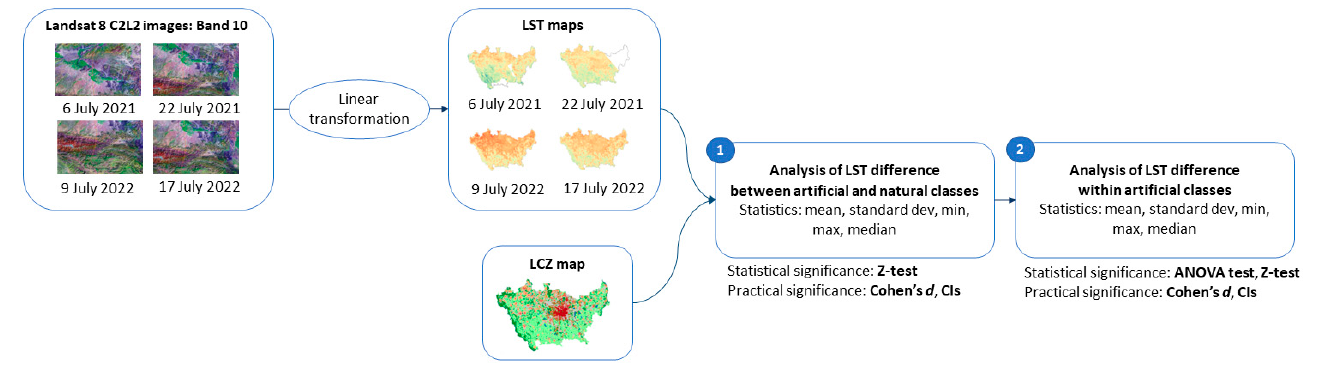
Figure 4. Flowchart adopted for LST analysis.